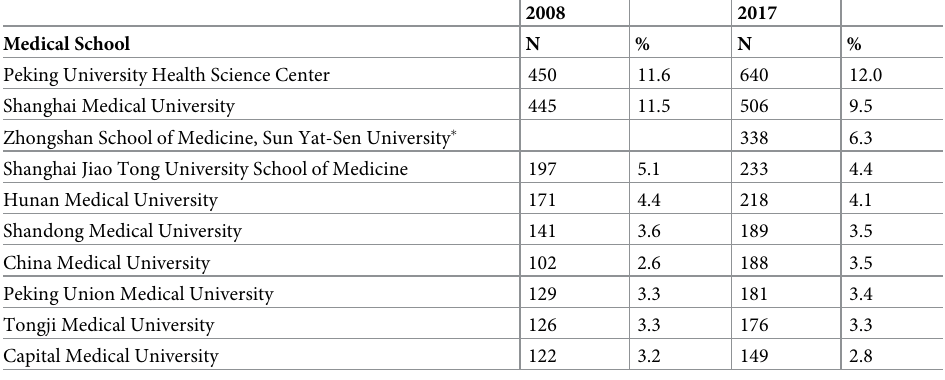
Table 2. The top 10 chinese medical schools for graduates practicing in the US (based on the 2008 and 2017 AMA Masterfile).